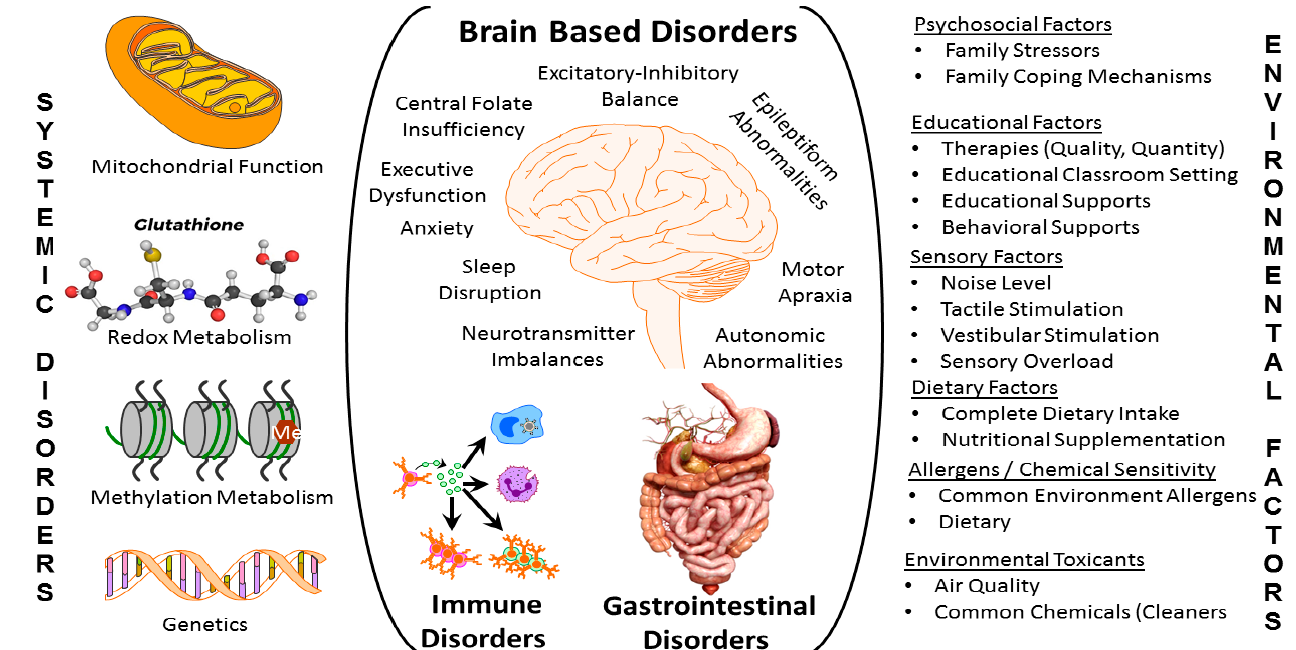
Figure 1. Potentially treatable abnormalities associated with Autism Spectrum Disorders (ASD). Overview of the multiple medical and associated potentially identifiably and treatable abnormalities associated with ASD. The center represents the specific organs commonly affected in ASD while the left column depicts the systematic medical abnormalities that may have widespread effects on multiple organs. The column on the right demonstrates multiple environmental factors that may modulate the severity of the underlying medical abnormalities.